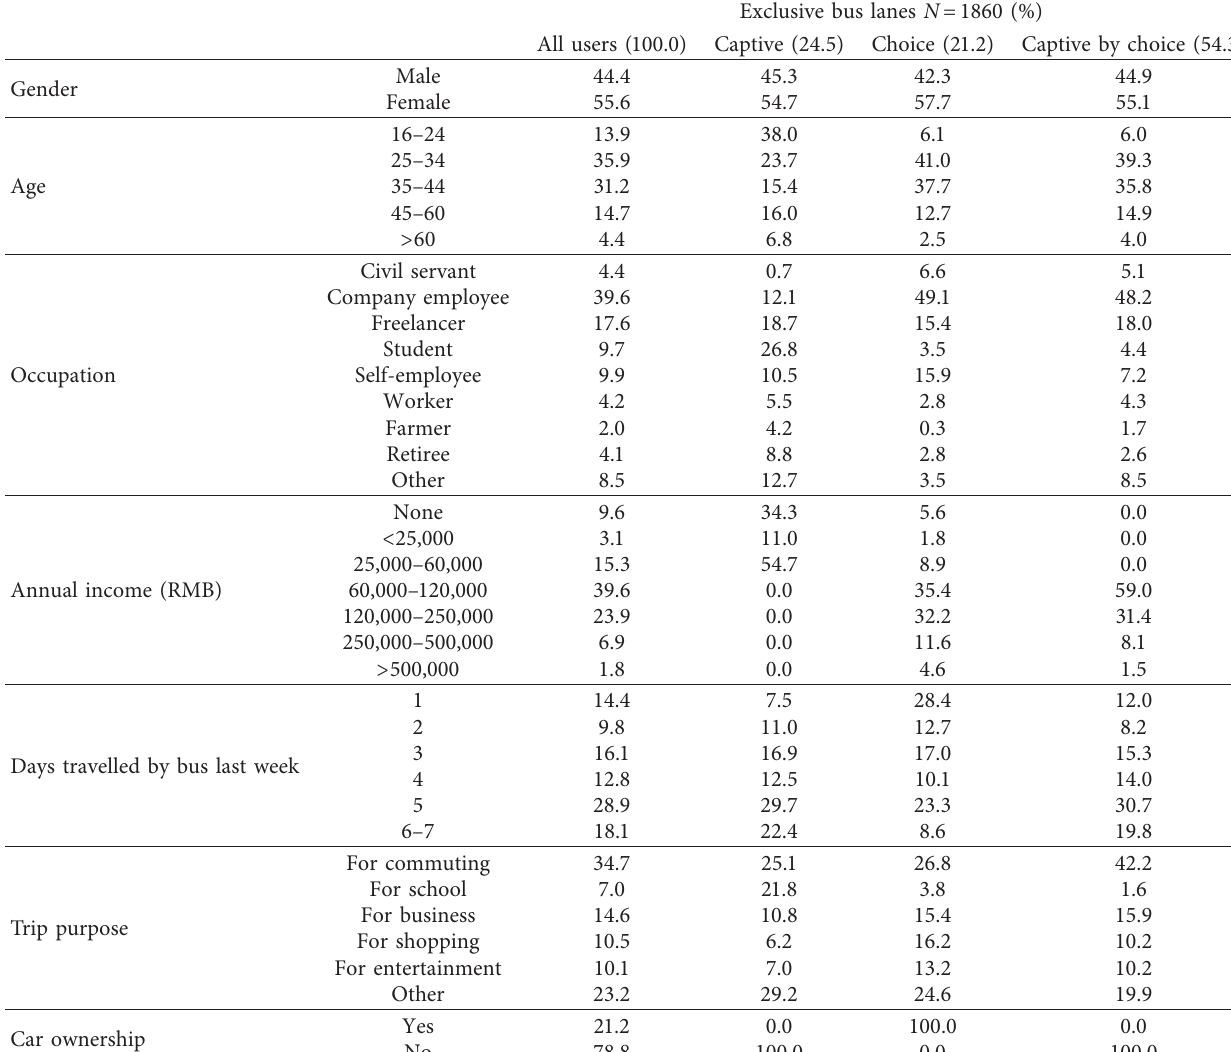
Table 3: Descriptive statistics of valid